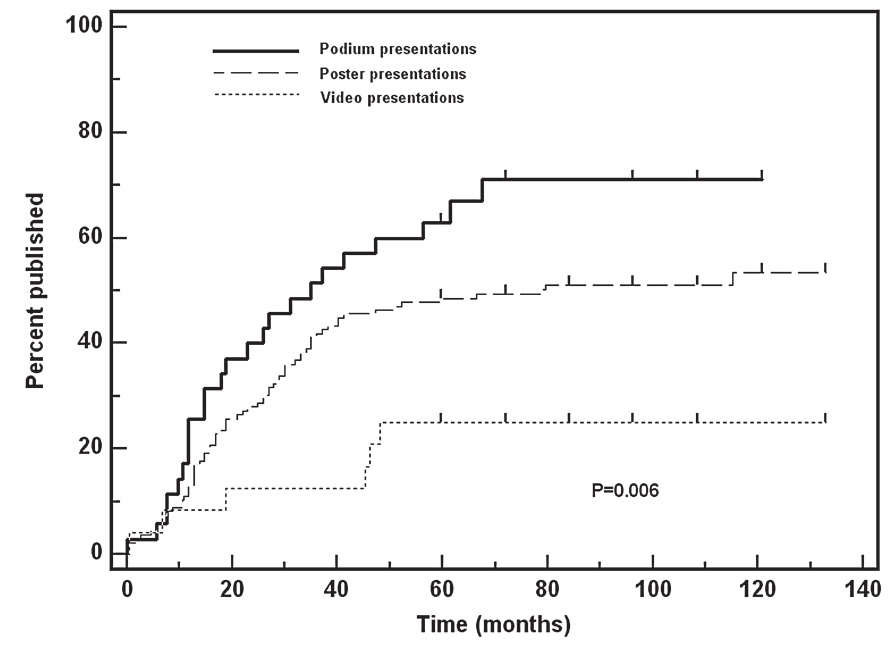
Figure 3 - Time to full publication of Brazilian studies, according to category of presentation at the American Urological Association Annual Meetings 2001 through 2007 (tick marks represent censoring).